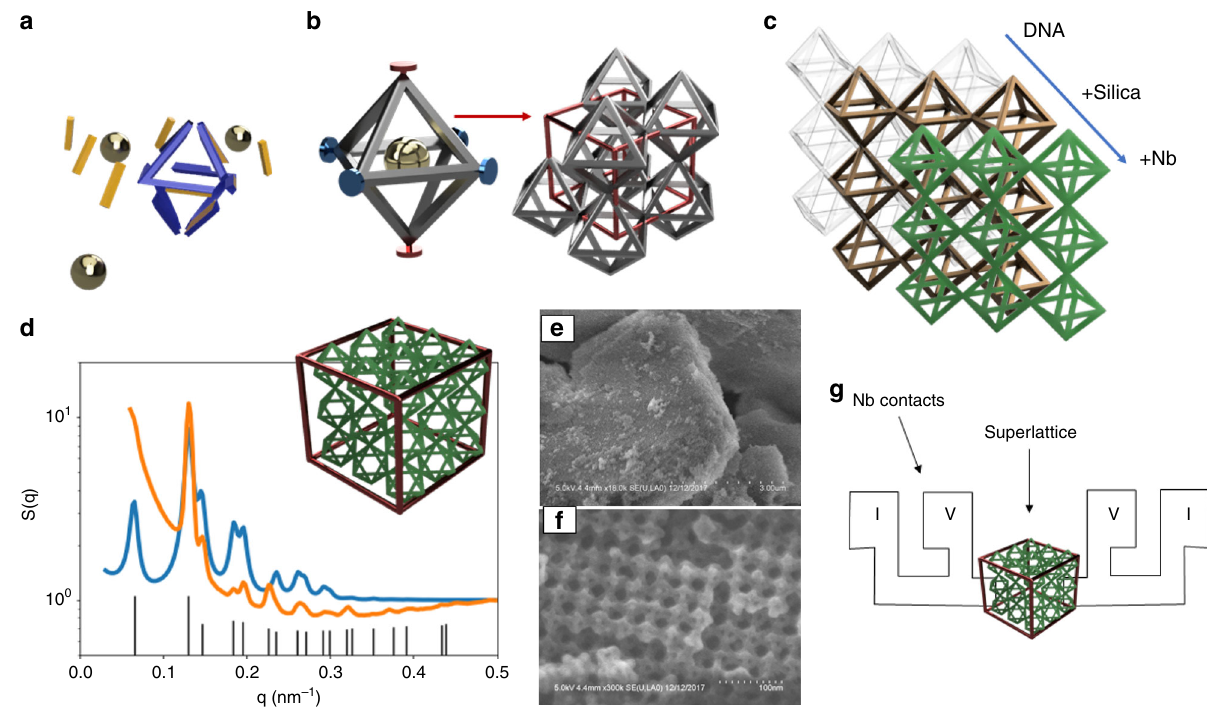
Fig. 1 Schematics of 3D superlattice assembly from octahedra DNA frames and gold nanoparticle, and its conversion into silica and superconductive structure. a DNA origami octahedral frames. b Integration of DNA frames with gold 10 nm nanoparticles and assembly of frames into superlattice with cubic unit cell. (AuNP used here for structural characterization and are not shown in other schematics). c Stepwise conversion process from DNA superlattices to SiO 2 and to Nb-coated structures. d Schematic of the formed simple cubic arrangement of octahedra frames. A tetragonal arrangement AuNP ’ s is determined by SAXS: data (orange), model (blue), indexed diffraction peaks, (001), (100), (101), (111), (002), (200) etc., are shown with vertical black lines. SEM micrographs of e large scale and f close up images of fabricated silica superlattices. g Schematic of low-temperature electrical measurement setup for Nb superlattice using four-point